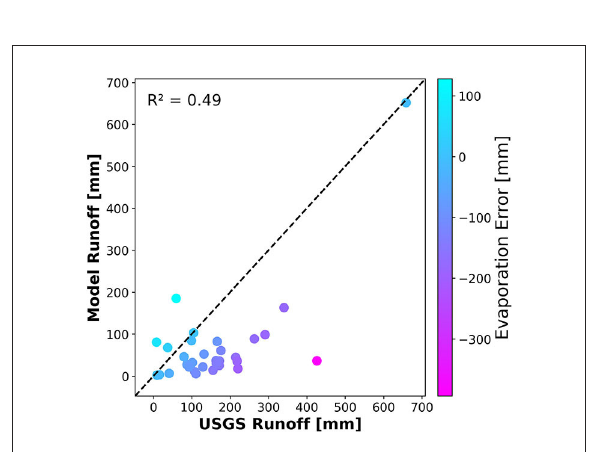
FIGURE13 Comparison of V4-LD-FX version vs. USGS gauge streamflow measurements for 31 selected basins. The color bar presents the difference in simulated and water budget evaporation during the 11-year